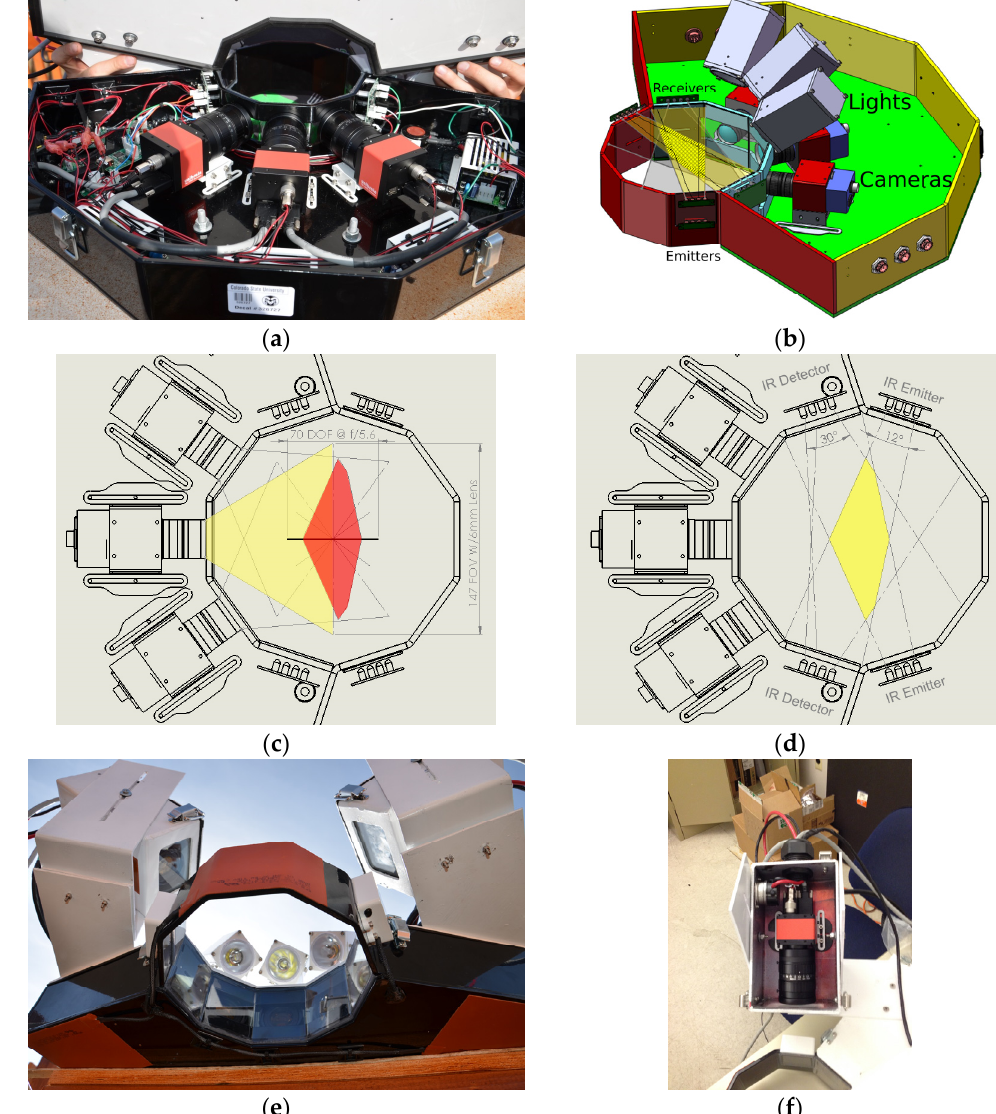
Figure 1. Multi-Angle Snowflake Camera (MASC): ( a ) photograph showing three cameras and electronic and mechanical components; ( b ) 3D schematic showing basic components (the “hatched” area represents the cross section for triggering of the near-IR motion detection system); ( c ) planar view of the prototype design with cameras having equal horizontal field of views (FOVs) and depth of fields (DOFs); and ( d ) precisely defined virtual measurement area ( yellow -colored area); ( e , f ) Adding two “external” cameras, in temperature controlled enclosures, to the Colorado State University (CSU) MASC, to improve 3D reconstruction of snowflakes.